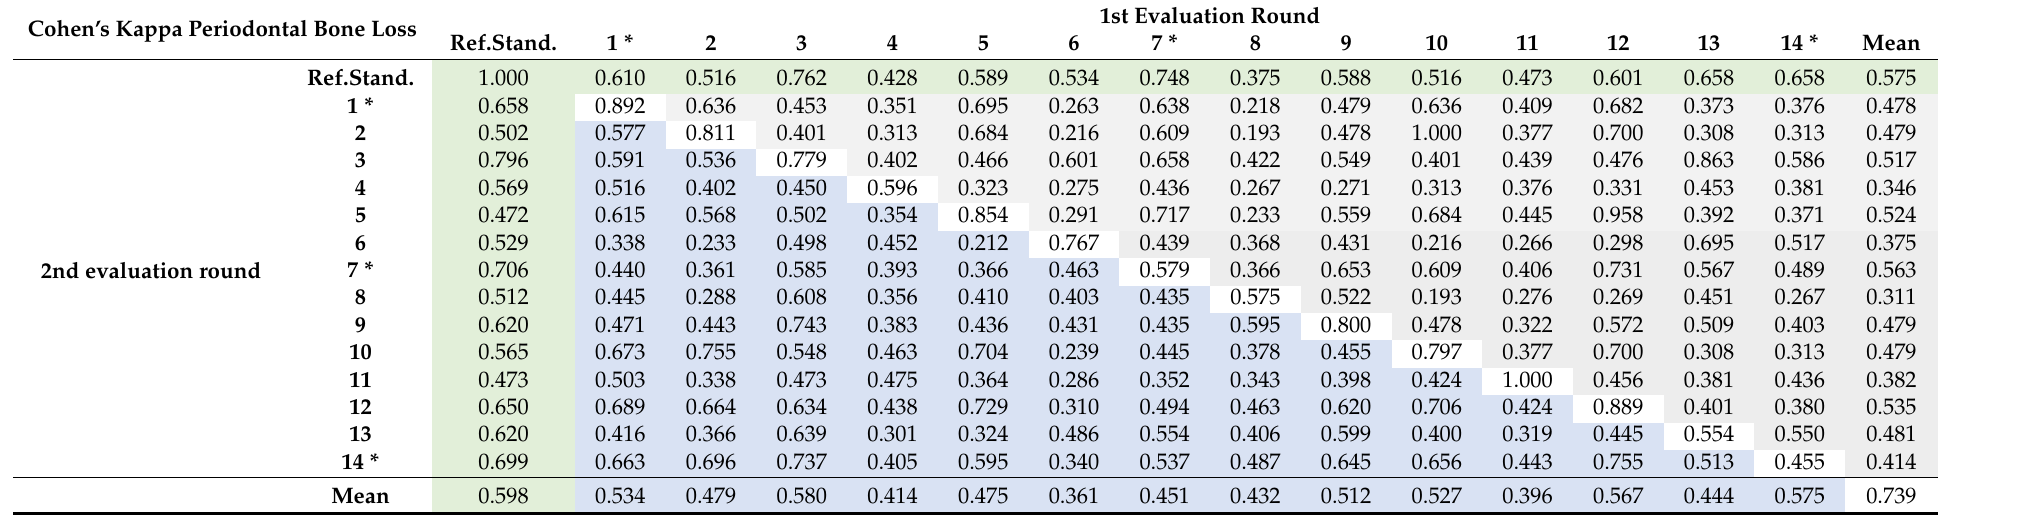
Table 3. Values of inter- and intra-rater reliability for the detection of PBL which was calculated among all dentists (N = 14) and in relation to the reference standard (green coloured boxes). Grey coloured boxes illustrate inter-rater CK values of the first assessment and blue coloured boxes for the second assessment. White fields indicate intra-rater CK